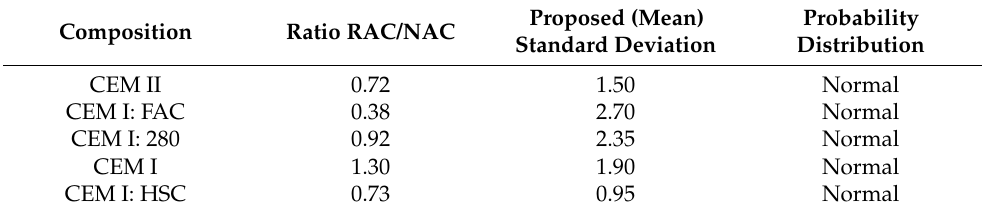
Table 4. Ratio of the standard deviations of RAC and NAC